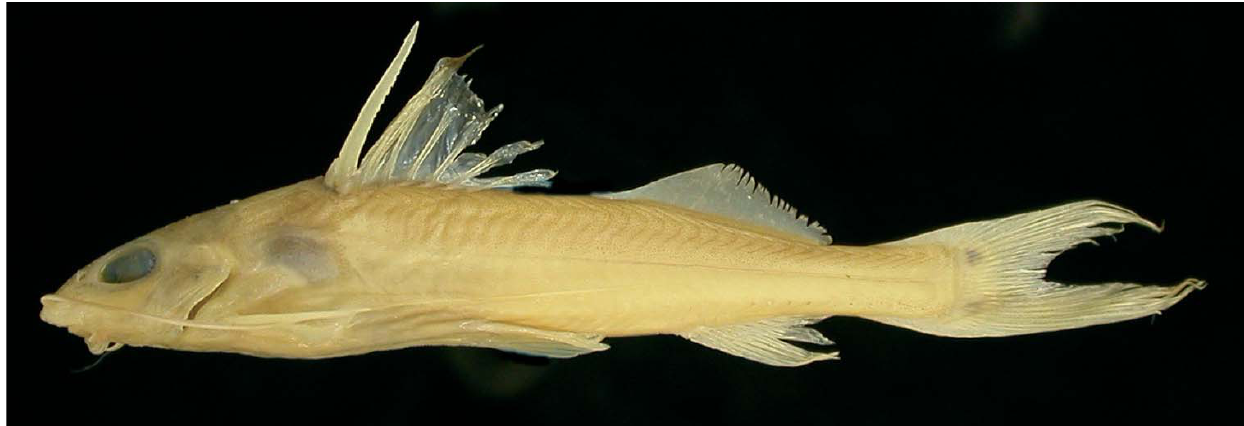
Fig. 4. Pimelodus joannis , holotype, MCP 41739, 51.0 mm SL, Ipueiras, rio Tocantins,